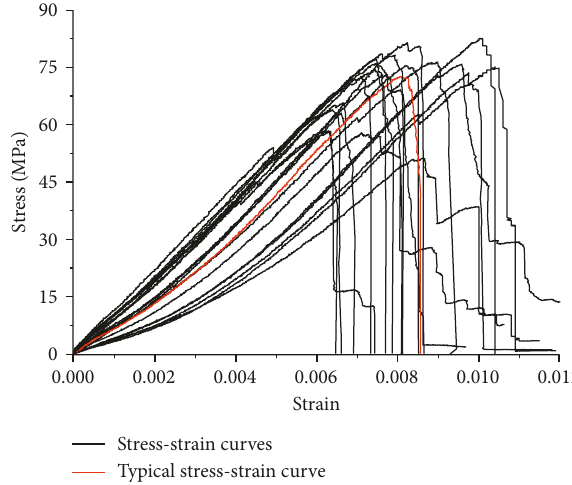
Figure 2: The stress-strain curves of sandstone under uniaxial